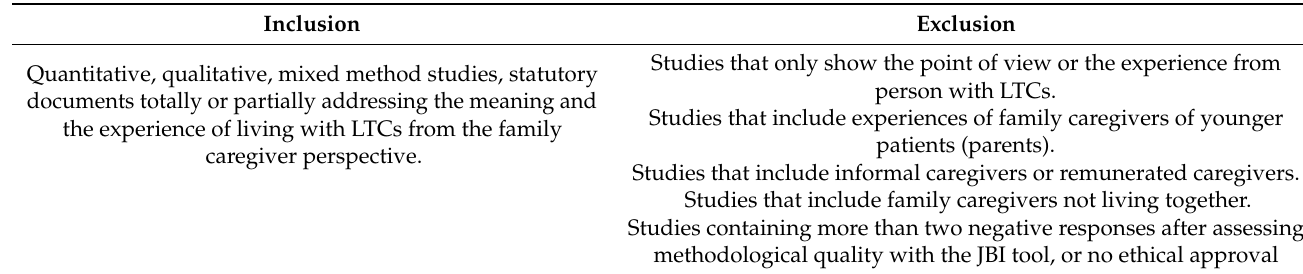
Table 2. Inclusion and exclusion